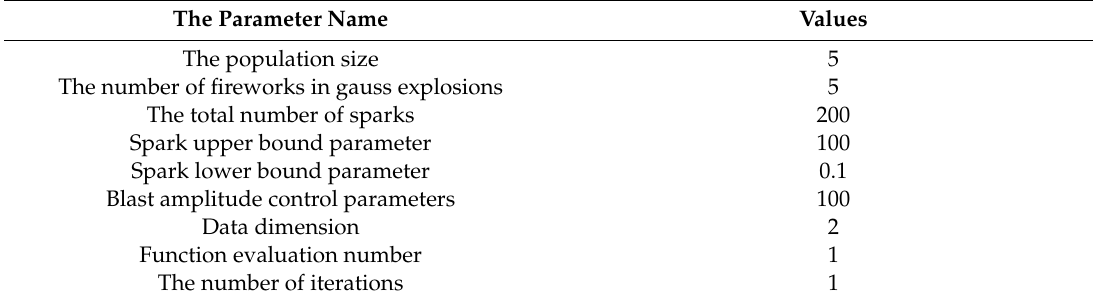
Table 6. Parameter settings of adaptive fireworks algorithm.